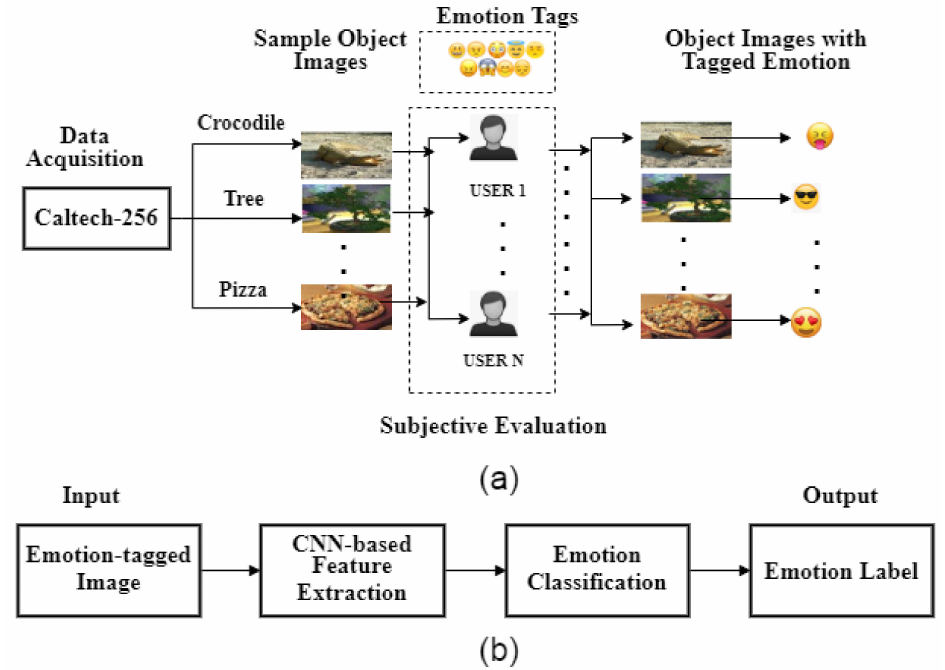
Figure 2. Block diagram of the proposed methodology. ( a ) Illustrates the subjective evaluation method applied to build an emotion-tagged dataset, and ( b ) shows the key steps taken to infer emotion tags, i.e., emotion